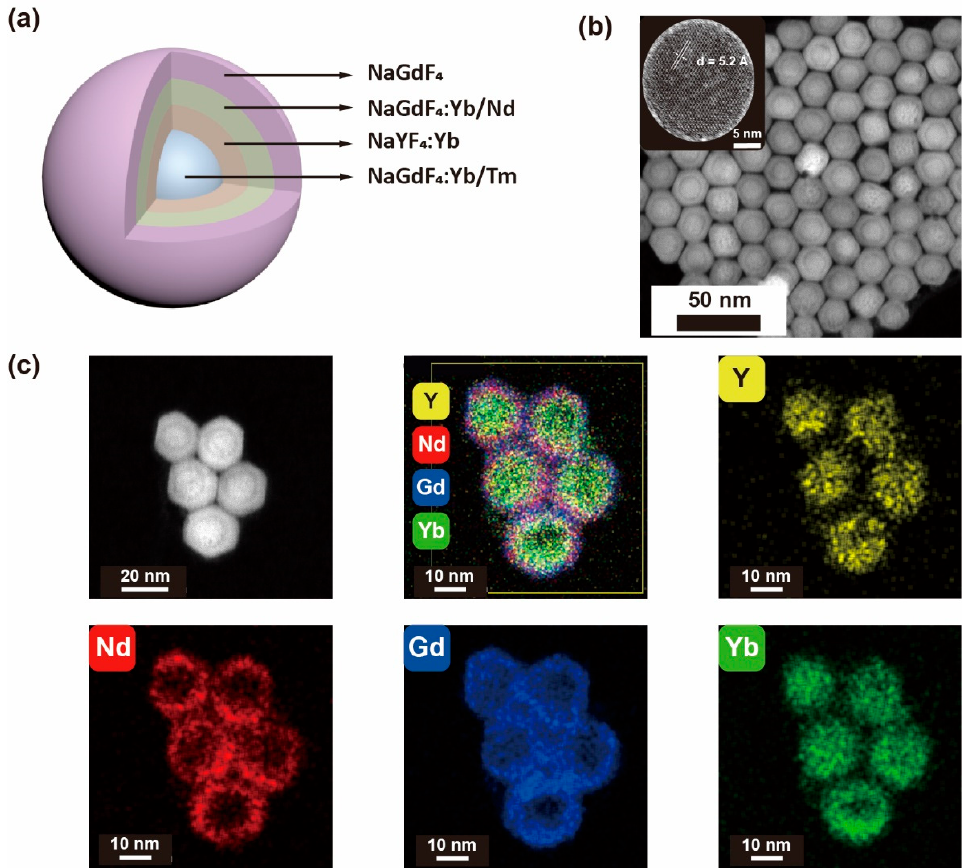
Figure 1. Schematic illustration and characterization of Gd ‐ CS Y S 2 S 3 heterogeneous nanoparticles. ( a ) Diagrammatic representation of Gd ‐ CS Y S 2 S 3 nanostructure. ( b ) High ‐ angle annular dark ‐ field scan ‐ ning transmission electron microscopy (HAADF ‐ STEM) image of Gd ‐ CS Y S 2 S 3 nanoparticles. Inset: high ‐ resolution TEM of as ‐ prepared Gd ‐ CS Y S 2 S 3 nanoparticle. ( c ) HAADF ‐ STEM image and ele ‐